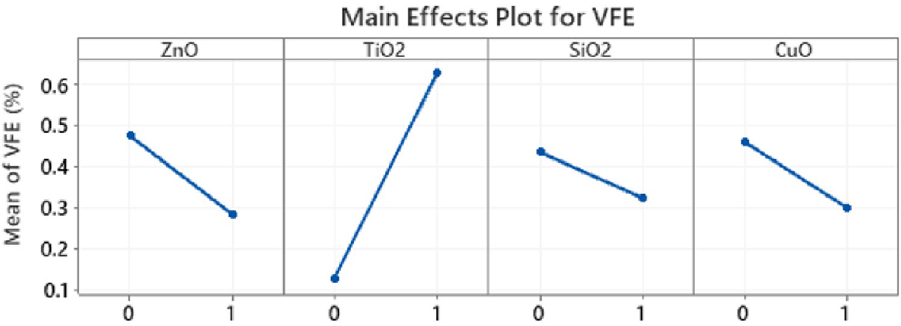
Fig 10. TiO 2 main contributor to VFE improvement while the contribution of other nanoparticles inconclusive in this surrogate testing with NaCl.